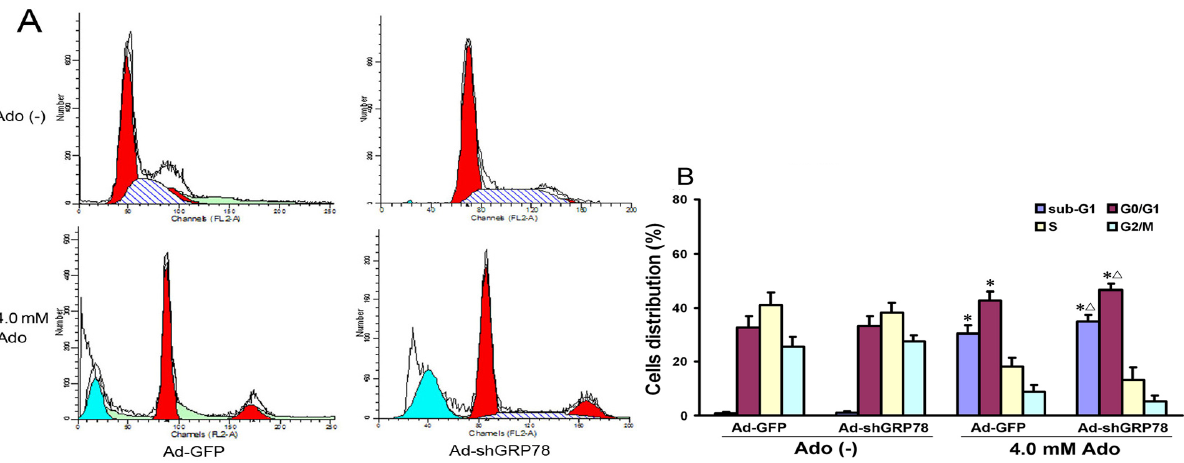
Figure 2. Effects of GRP78 knockdown on cell cycle distribution and apoptosis (sub-G1). HepG2 cells were transfected with either Ad-GFP (negative control) or Ad-shGRP78. After incubation for 24 h, cells were incubated with or without 4.0 mmol/L adenosine for an additional 24 h, and the cell cycle phases were determined by propidium iodide staining, followed by FACS flow cytometric analysis ( A ); The values represent the means ± SD of three independent experiments ( B ). * p < 0.05, vs. negative control group (vector only treatment); Δ p < 0.05, vs. the positive control group (adenosine